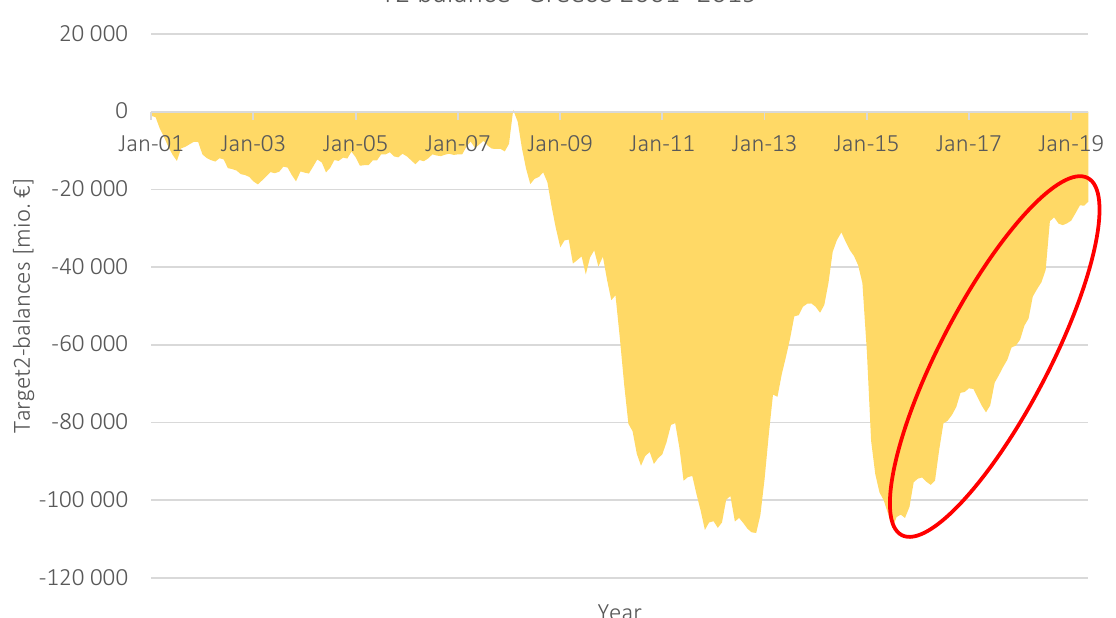
Figure 2. T2 balances of Greece in billion